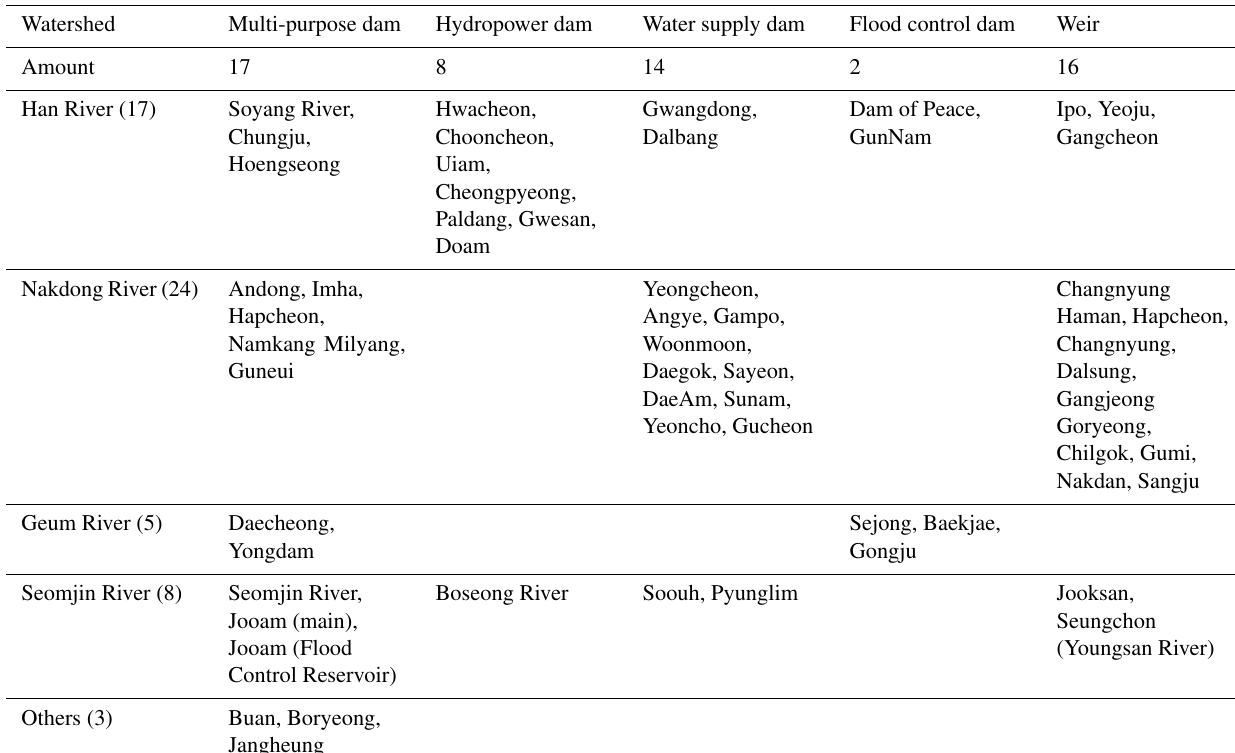
Table 1. Dams for conjunctive operation per watershed. Watershed Multi-purpose dam Hydropower dam Water supply dam Flood control dam Weir Amount 17 8 14 2